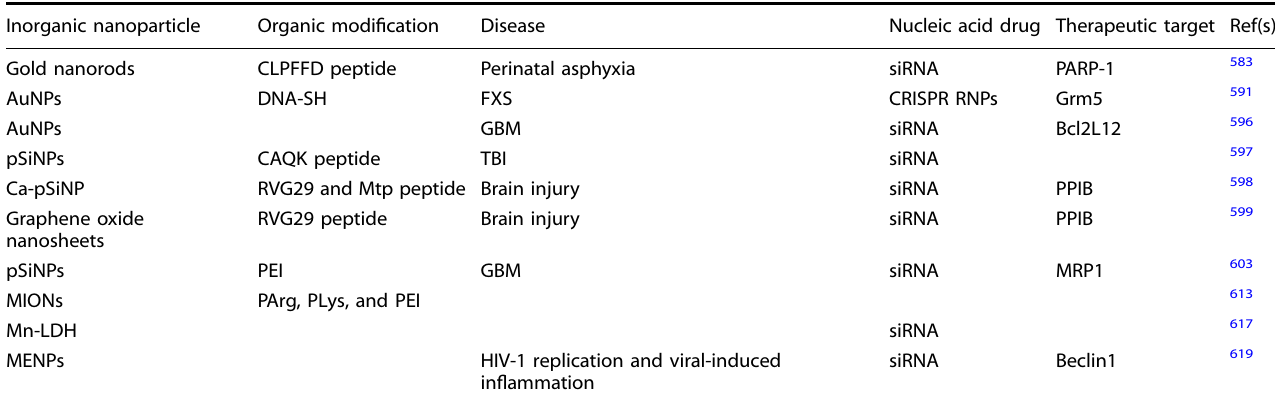
Table 4. Inorganic nanoparticle-based vectors for nucleic acid drug delivery Inorganic